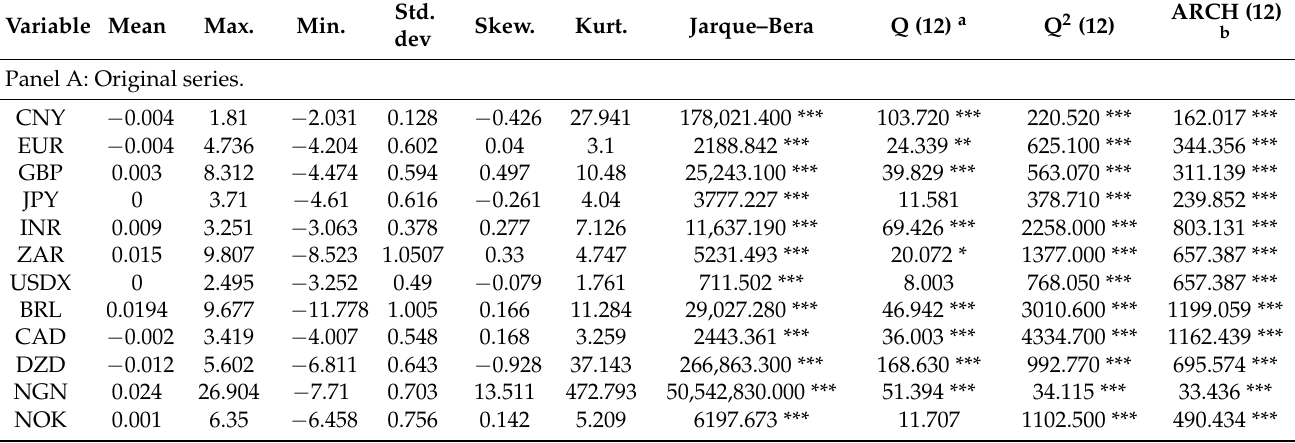
Table 1. Summary statistics for the crude oil and exchange rate returns and their respective idiosyn- cratic